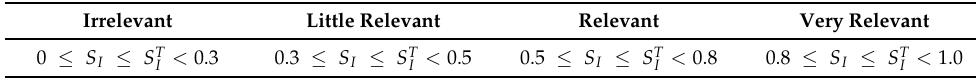
Table 3. Relevance of the Sobol